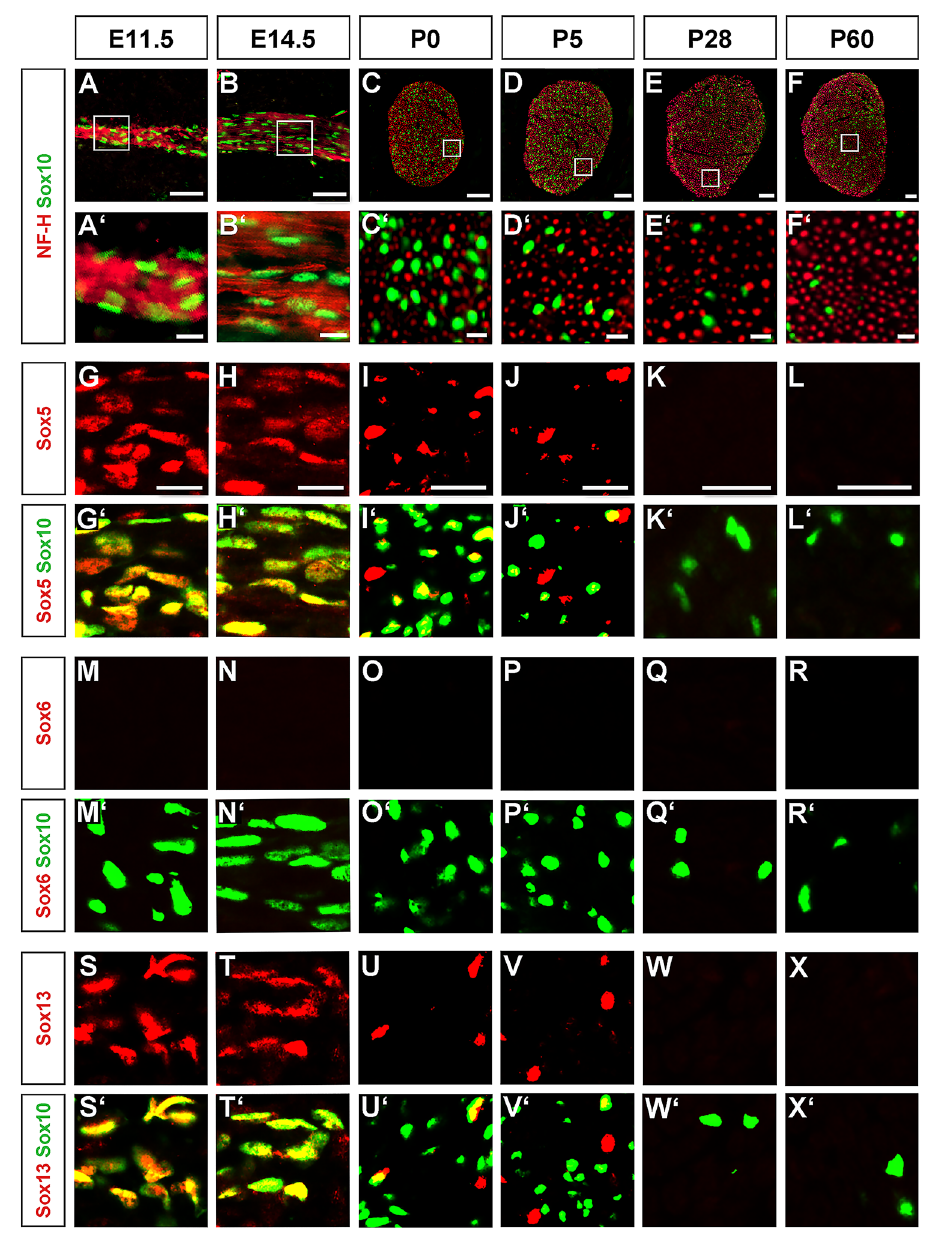
Figure 1. Analysis of SoxD expression in developing and adult Schwann cells. After localization of peripheral nerves by neurofilament staining ( A–F,A ′ –F ′ , in red), co-immunohistochemistry was used to determine expression of Sox5 ( G–L ), Sox6 ( M–R ) and Sox13 ( S–X ) (all in red) in Sox10-positive Schwann cells ( A–F,A ′